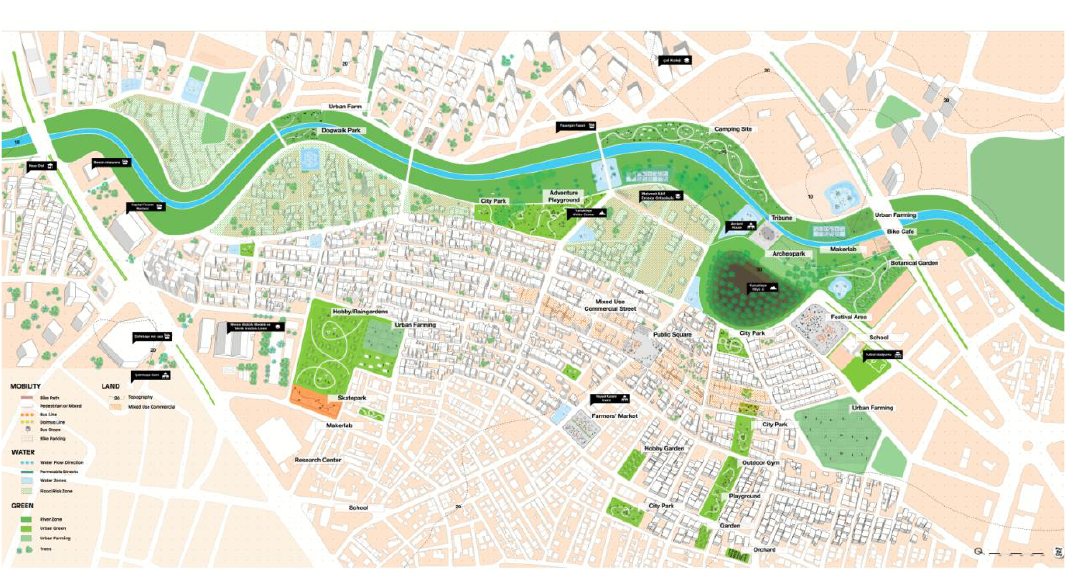
Figure 15 Results of participants’ proposals related to land -use, mobility and urban water management strategies in neighborhood